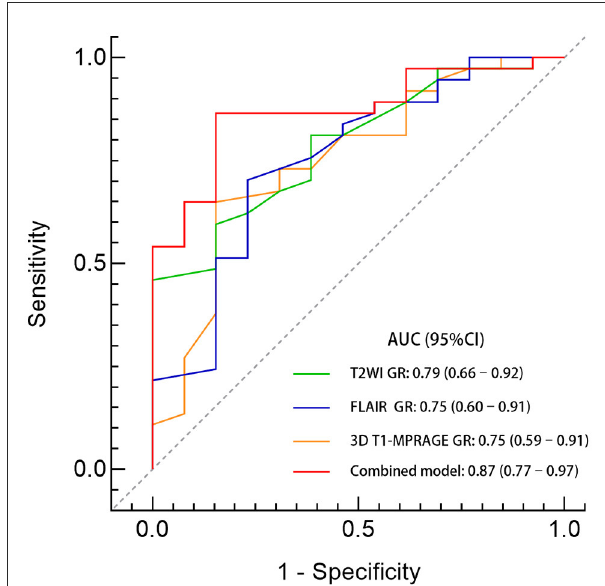
FIGURE3 Comparison of predictive performance between the GR values of different sequences. A GR ratio of < 0.69 on 3D T1-MPRAGE images combined with a GR ratio of > 1.34 on T2WI images and a GR ratio of > 1.12 on FLAIR images identified those with a seizure freedom outcome. The AUC of the combined model was 0.87 (95% CI, 0.77–0.97; p < 0.001) with a sensitivity of 86% and a specificity of